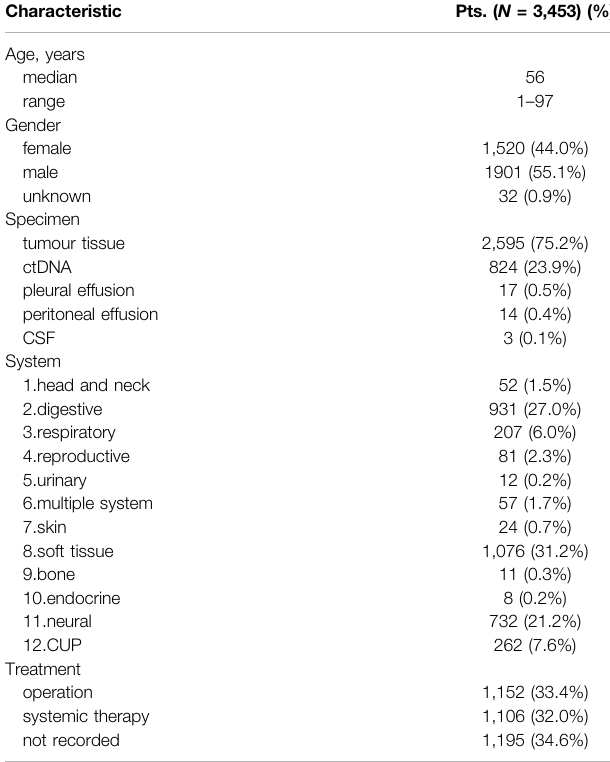
TABLE 1 | Clinicopathological characteristics of patients.